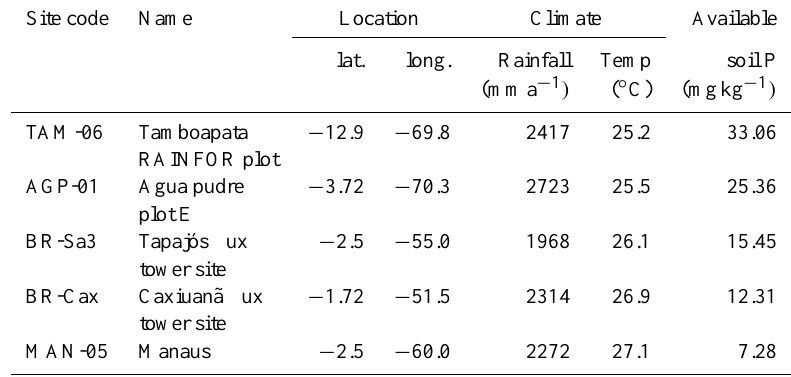
Table 2. Site code, locations and climatic characteristics of the five Amazonian sites used in this study. Site code Name